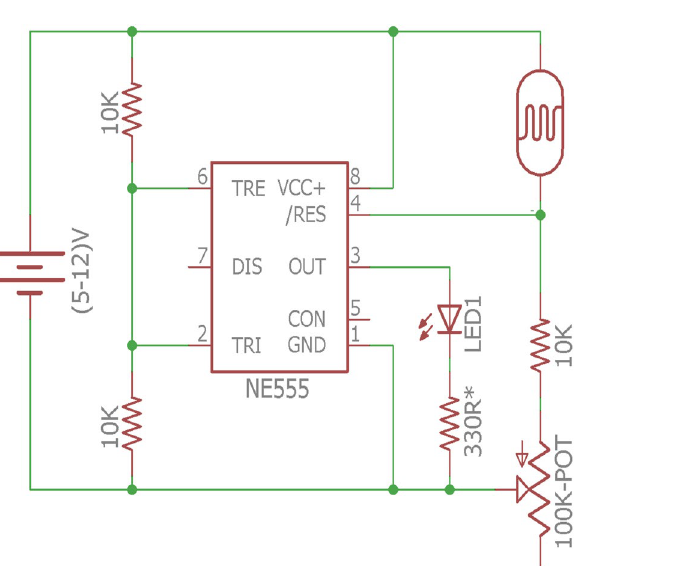
Figure 5. Circuit diagram of the developed seedling picking mechanism (SPM).